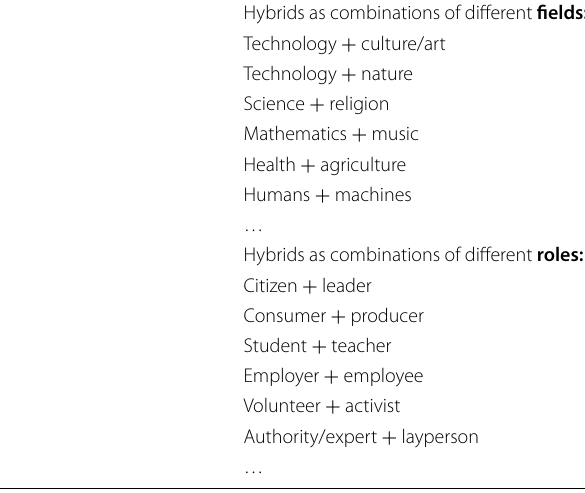
Table 1 Four categories of hybrids as a typology Hybrids as combinations of different characteristics: Hybrids as combinations of different